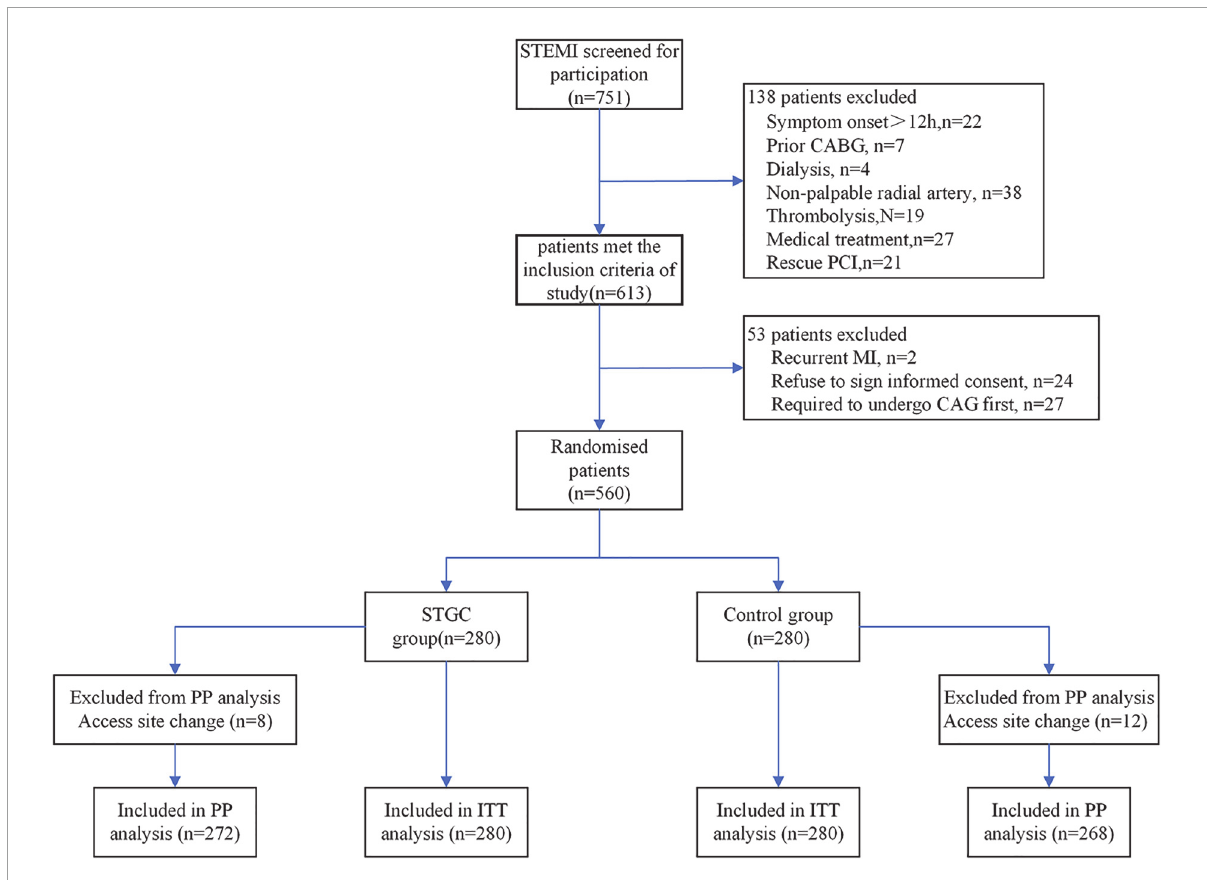
FIGURE1 Trial flowchart. CABG, coronary artery bypass graft; ITT, intention-to-treat; PP, per-protocol.